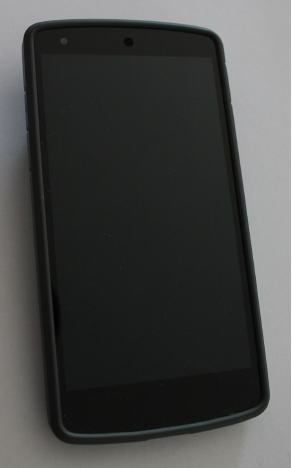
Figure 2. LG Google Nexus